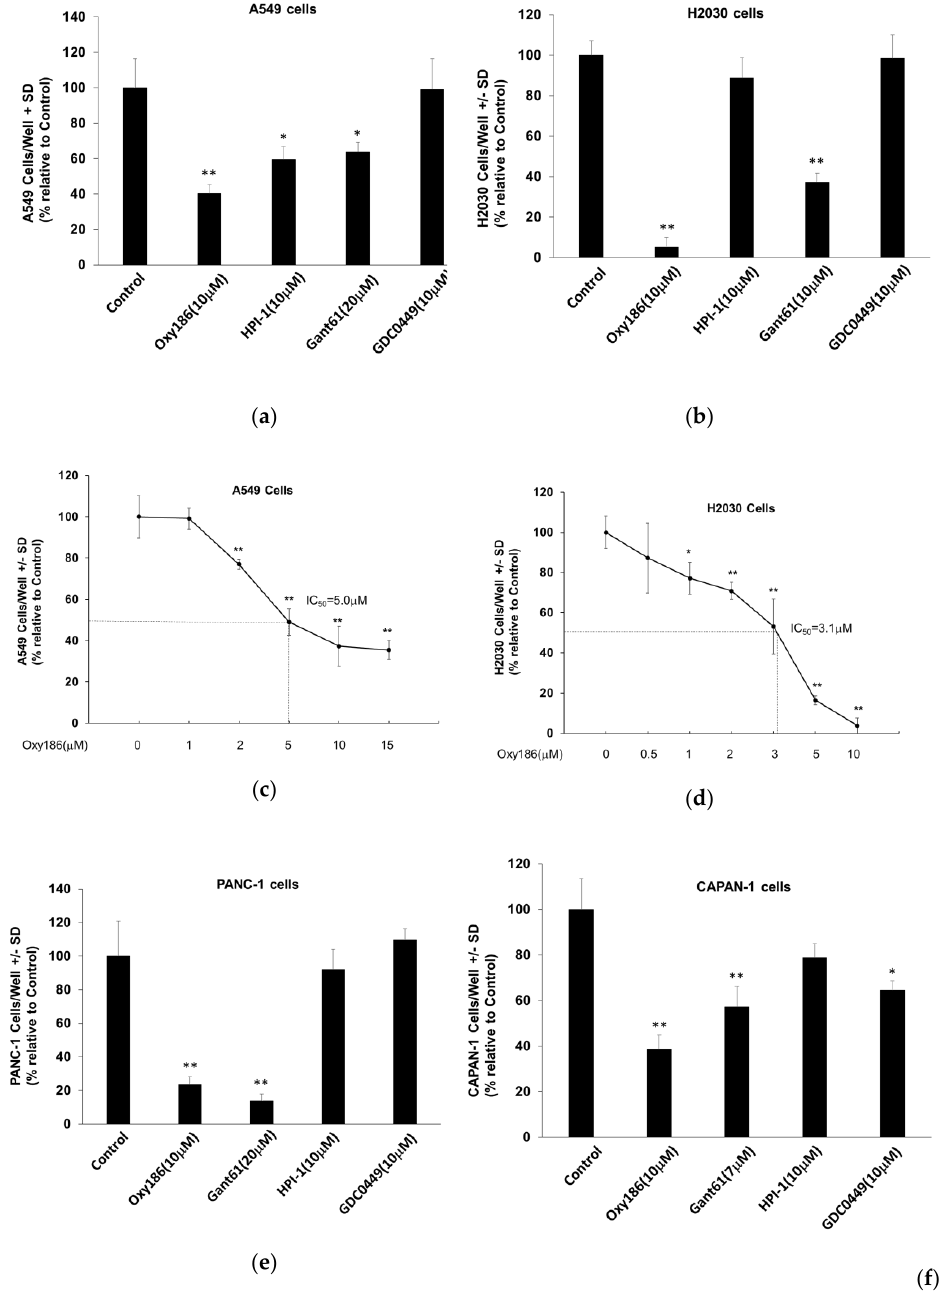
Figure 6. Inhibition of human pancreatic and lung cancer cell proliferation by Oxy186. ( a , c ) A549, ( b ) and ( d ) H2030, ( e ) PANC-1, and ( f ) CAPAN-1 cells were treated with the compounds as indicated in RPMI 1640 ( a – d ) or DMEM ( e , f ) containing 5% FBS for 96 h and then were trypsinized and counted. Data from a representative experiment are reported as the mean of triplicate determinations ± SD (* p < 0.05 vs. Control; ** p < 0.01 vs. control).